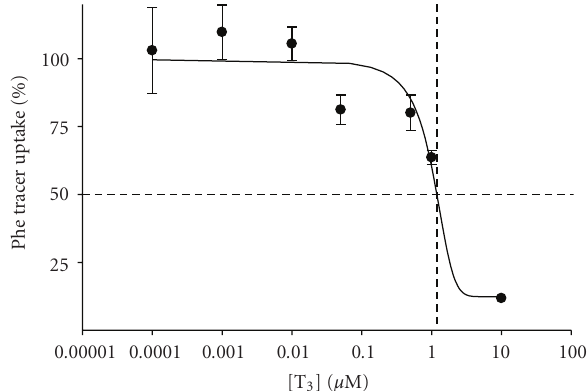
Figure 4: Concentration dependence of the inhibitory e ff ect of tri-iodothyronine on phenylalanine uptake into 3T3-L1 adipocytes. Uptake of [ 3 H]phenylalanine was measured at 5 μ M over 3 minutes in the presence of 7 di ff erent T 3 concentrations as indicated (between 100 pM and 10 μ M). Values are expressed as % of control phenylalanine uptake (measured in the absence of T 3 ). The dotted lines indicate that 50% inhibition is achieved with 1.2 μ M T 3 , estimated as the K i for T 3 inhibition of phenylalanine uptake in these